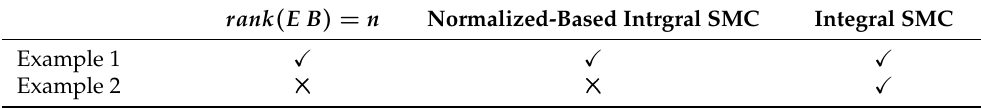
Figure 4. State responses of the integral sliding mode control (SMC). Table 1. Comparison between Example 1 and Example